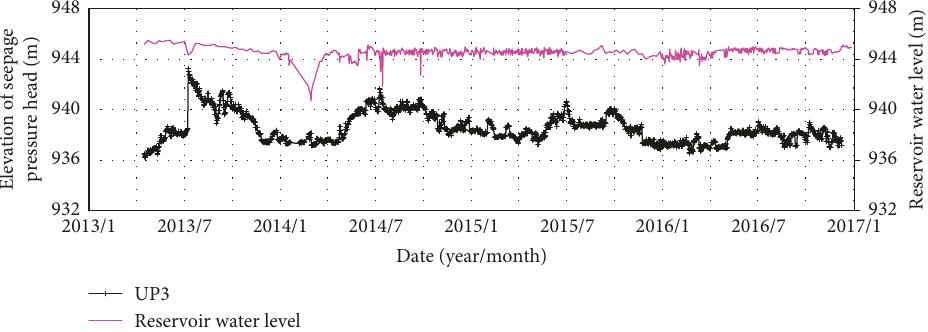
Figure 7: Time series for seepage pressure head at UP3 and reservoir water level.